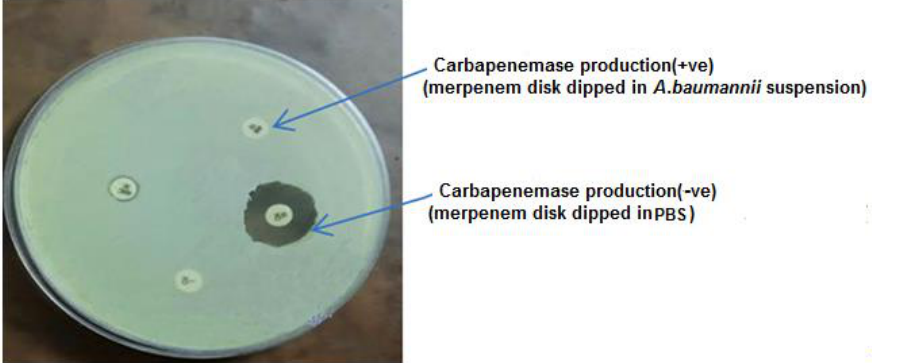
Figure 2. Ability of A. baumannii for Carbapenemase production.